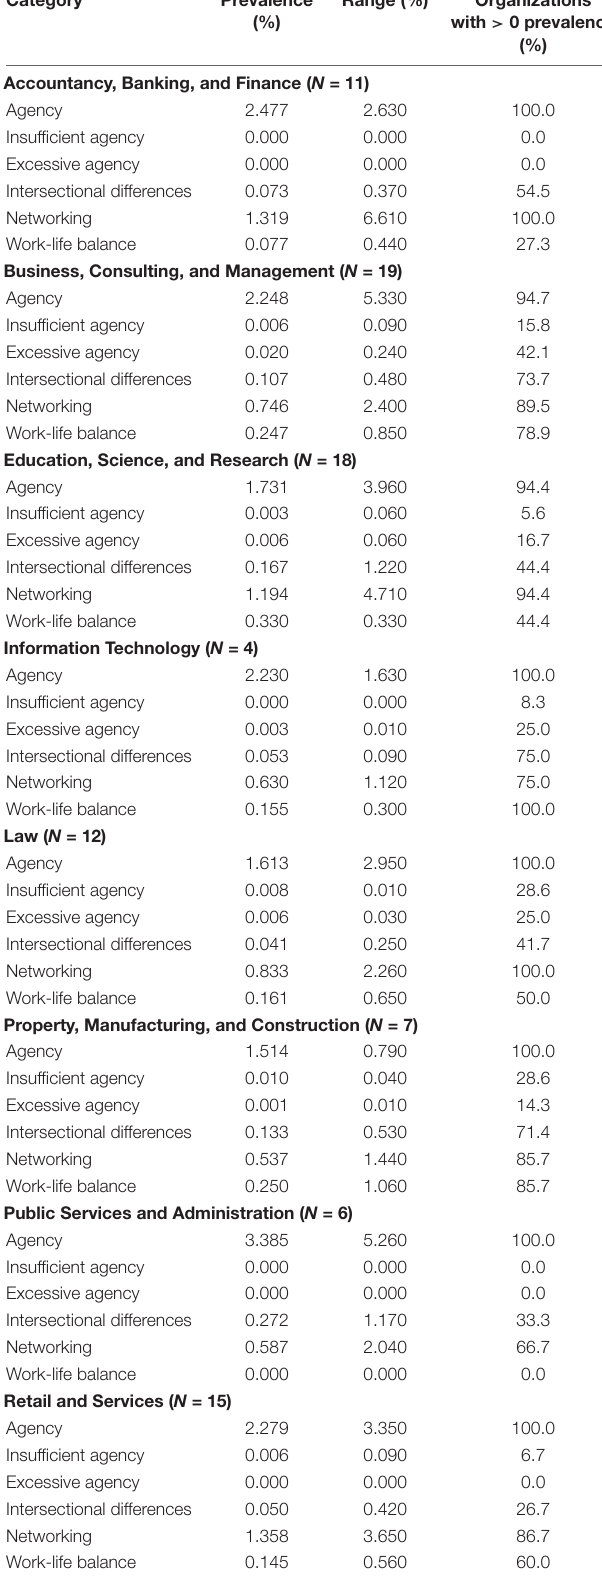
TABLE 6 | Prevalence of intervention needs per